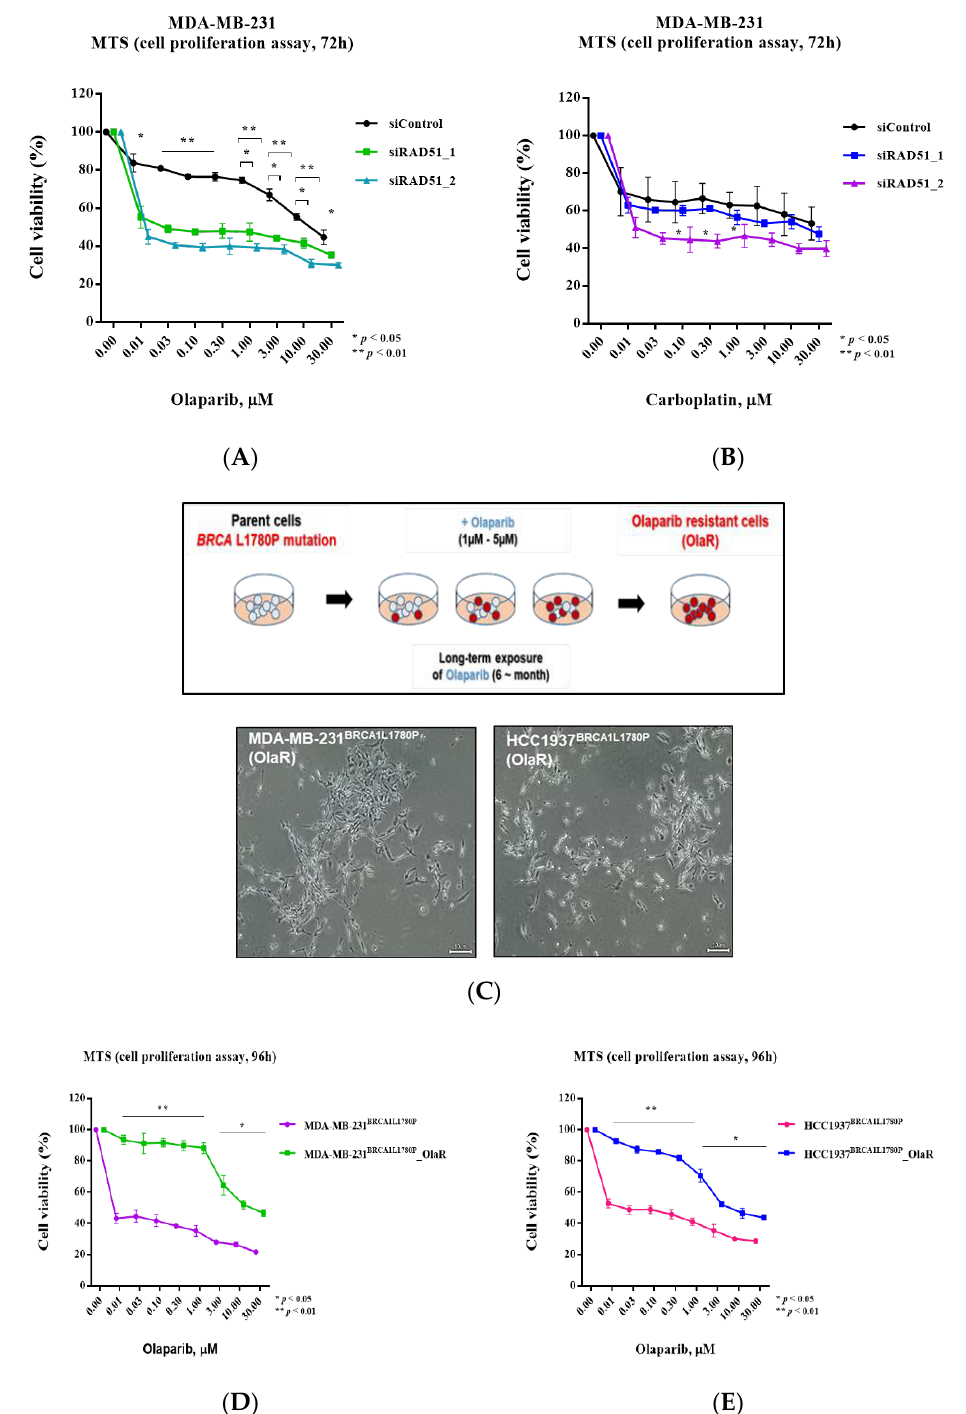
Figure 6. RAD51 expression level affected olaparib sensitivity in BRCA-proficient cells. ( A , B ) Downregulation of RAD51 expression affected sensitivity to ( A ) olaparib, and ( B ) carboplatin in MDA-MB-231 cells. ( C ) Schematic diagram showing the establishment of olaparib-resistant cell lines. ( D , E ) Cell proliferation assay was performed to evaluate the cell viability of parental and olaparib-resistant cell lines following olaparib treatment. Olaparib-resistant cells derived from cells stably expressing BRCA1 L1780P mutant in ( D ) MDA-MB-231 and ( E ) HCC1937 cell lines. Data are reported as the mean ± standard deviation (SD). Statistical analysis was performed using the chi-square test. (* p < 0.05, ** p < 0.01).